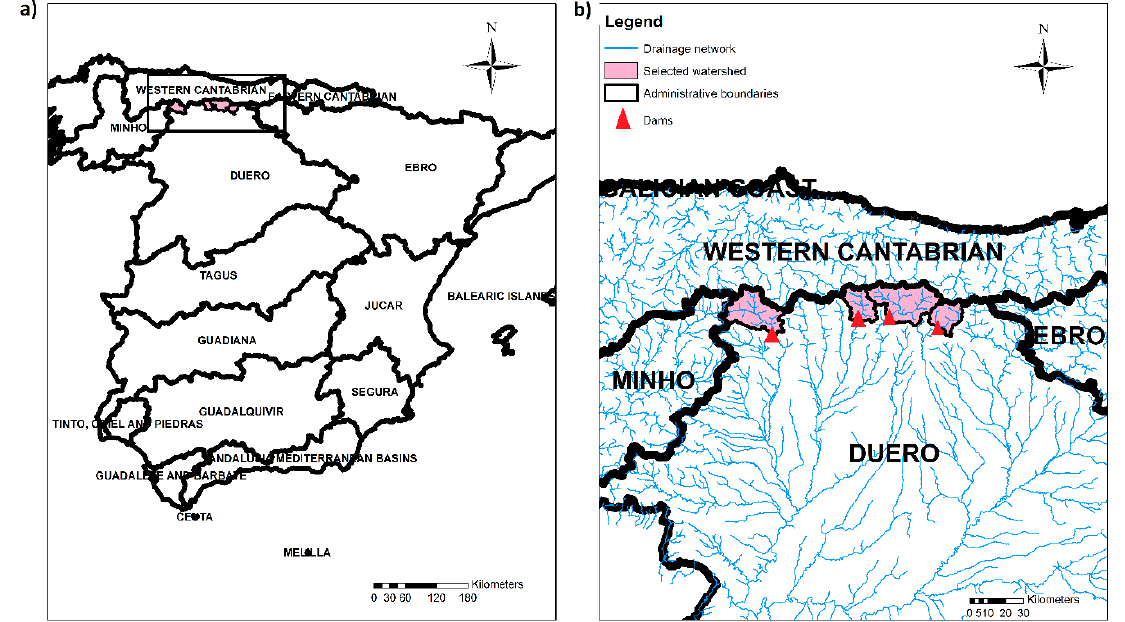
Table 1. Catchment characteristics.